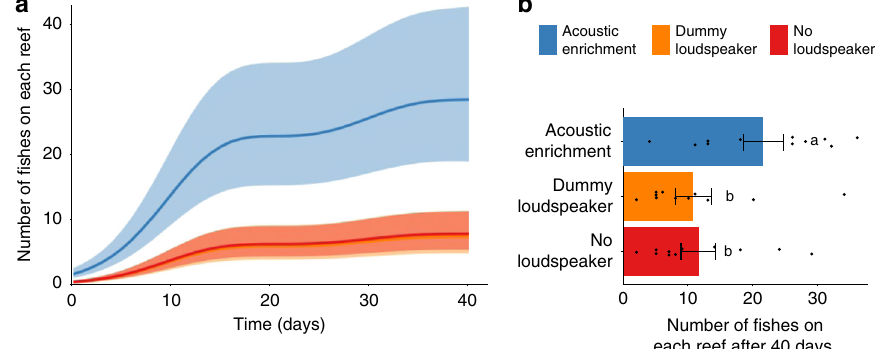
Fig. 1 Effect of acoustic enrichment on damsel fi sh community development. a Outputs from a generalised additive mixed model, modelling number of juvenile damsel fi sh per reef (mean ± SE) over time based on repeated surveys; orange and red lines and ribbons are almost completely overlapping. b Raw count data of number of juvenile damsel fi sh per reef (mean ± SE) from surveys undertaken after 40 days. Different letters associated with bars represent signi fi cant differences in post-hoc Tukey ’ s HSD tests, following a signi fi cant effect of loudspeaker treatment in a generalised linear mixed model (see Supplementary Table